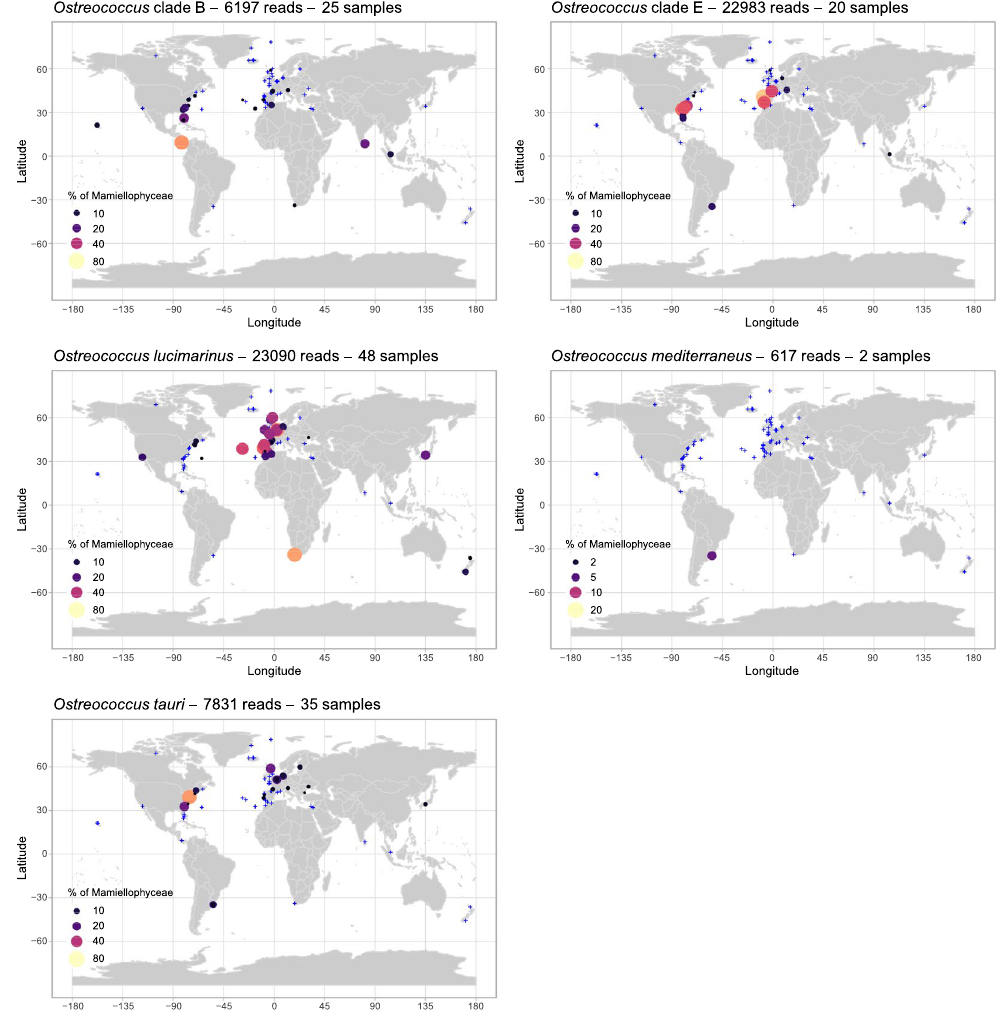
Figure 3. Distribution of the major Ostreococcus ASVs for OSD2014 (LGC). The three major O . tauri ASVs have been pooled together. Circle surface corresponds to the percentage of ASV reads relative to the total number of Mamiellophyceae reads. Samples for which the contribution of the ASV was lower than 1% or where it was absent are represented by blue crosses. A zoomed-in map of European waters is provided in Fig.